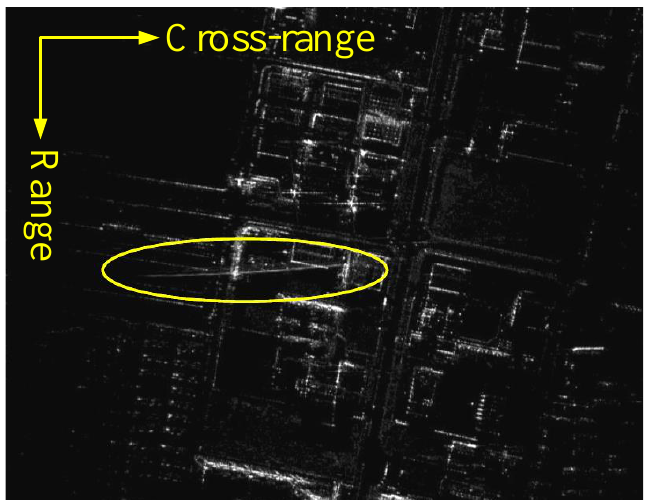
Figure 10. The stationary scene image containing moving target T2.